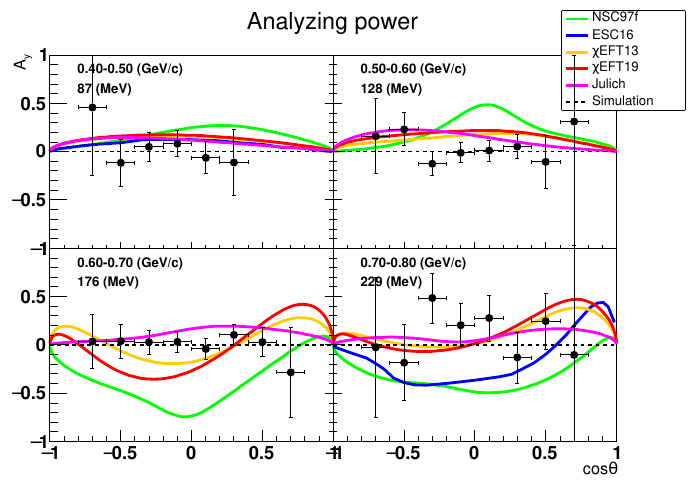
Figure 1. Simulated results for A y measurement of the Λ p scattering in the momentum range from 0.4 to 0.8 GeV / c with 0.1 GeV / c momentum interval for 5 × 10 7 Λ beam. Two types of Nijmegen models (NSC97f and ESC16 [17]) and Jülich model [28] are presented as the typical example of the boson exchange picture. The two results by chiral EFT (chiral EFT13 and 19) [7, 8] are calculated with the di ff erent sets of the LEC parameters both of which reasonably reproduce the YN scattering cross